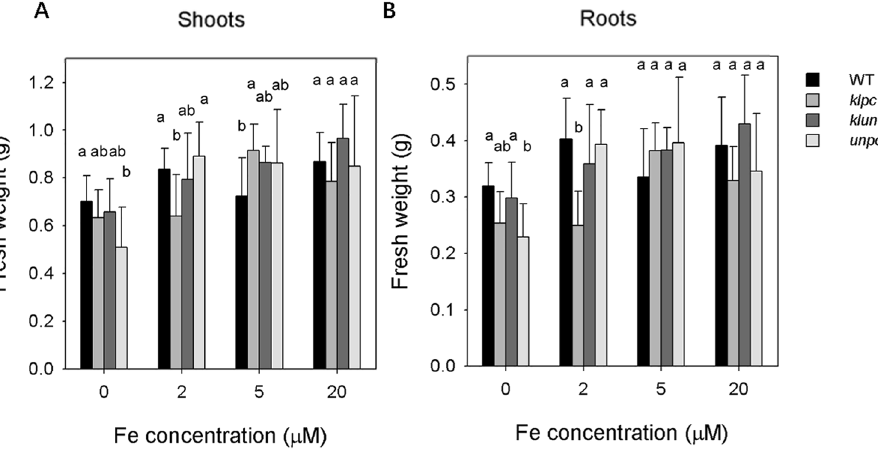
Figure 2. Growth performance of Wt and 14-3-3 qKOs under different Fe deficiency treatment. After two weeks of growth on ½ strength Hoagland solution, plants were grown for an additional 12 days at 0, 2, 5 and 20 μM Fe. Fresh weight of roots ( A ), and shoots ( B ) were measured from Wt and 14-3-3 qKOs plants. Values are means ± SD (n = 10). Different letters above the column indicate that the values are significantly different at p < 0.05 according to Tukey’s